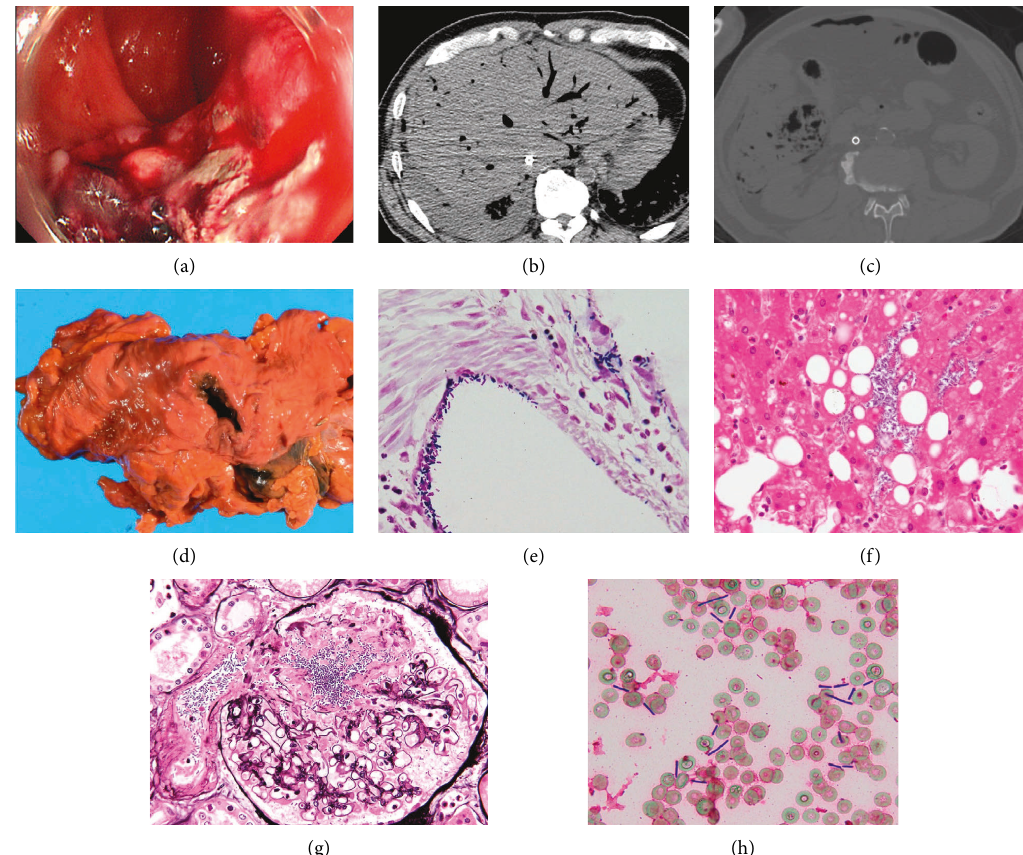
Figure 1: (a) Endoscopy at diagnosis showed a type 2 tumor in the hepatic curvature of the ascending colon. (b)–(c) Autopsy imaging shows gas retention in the tumor and metastasis of the liver and portal vein. There was also free air in the abdominal cavity, suggesting perforation of the gastrointestinal tract. (d) In the pathological autopsy, the foul-smelling gas was removed upon opening the abdomen, and the tumor area in the colon was perforated. (e) Numerous Gram-positive bacilli were found in the perforation of the colon tumor. (f) Numerous Gram- positive rods were found in the liver with gas production. (g) In the kidney, the fungus destroyed the glomerular appendages. (h) Gram staining of the blood confirmed Gram-positive